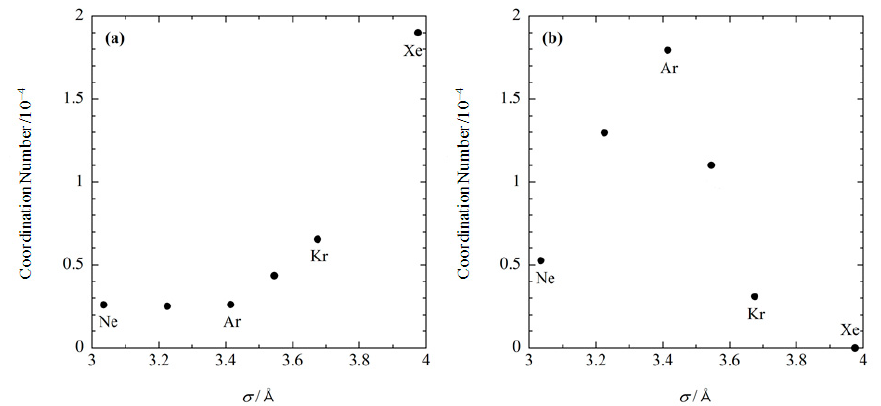
Figure 5. The size dependence of noble gases bound at ( a ) the substrate binding site, and ( b ) the internal site. (The figure is reprinted from Ref. [54]. Copyright (2007) American Chemical